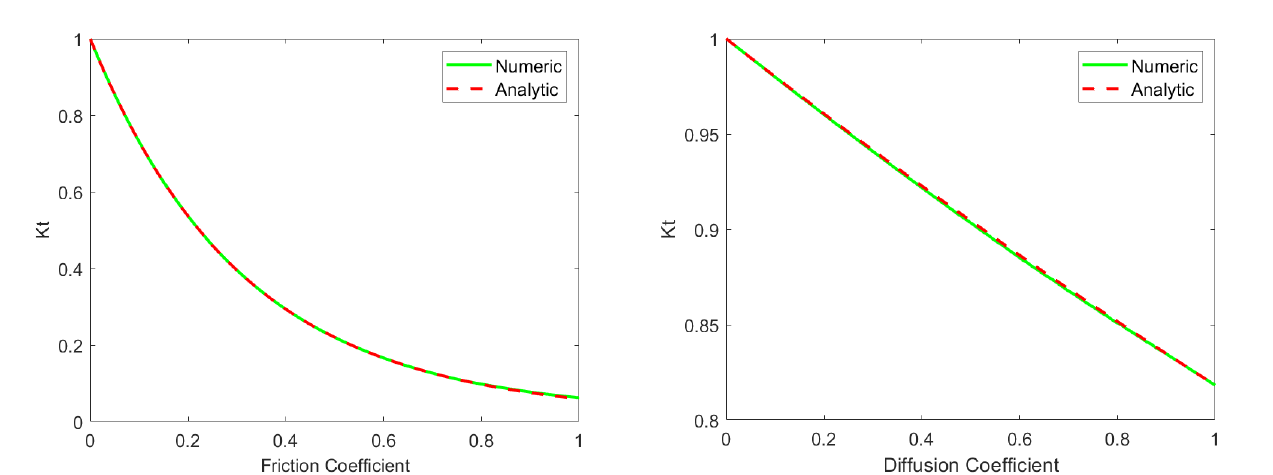
Figure 6. Numerical and Analytical Comparison Between Transmission Coefficient K t and ( left ) Friction Coefficient, c f ( right ) Diffusion Coefficient, c D